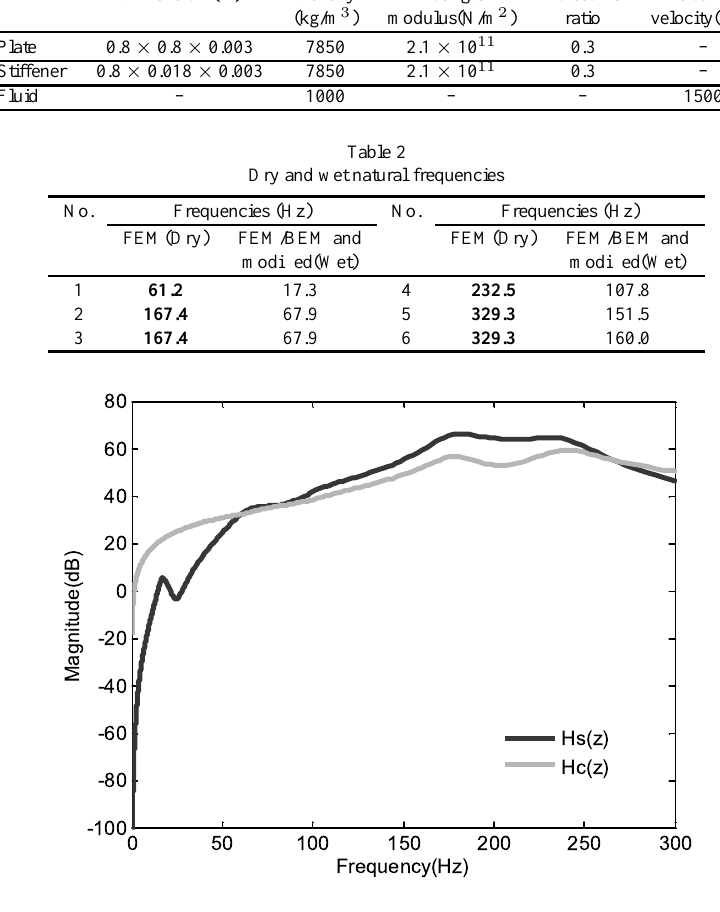
Fig. 6. Frequency response